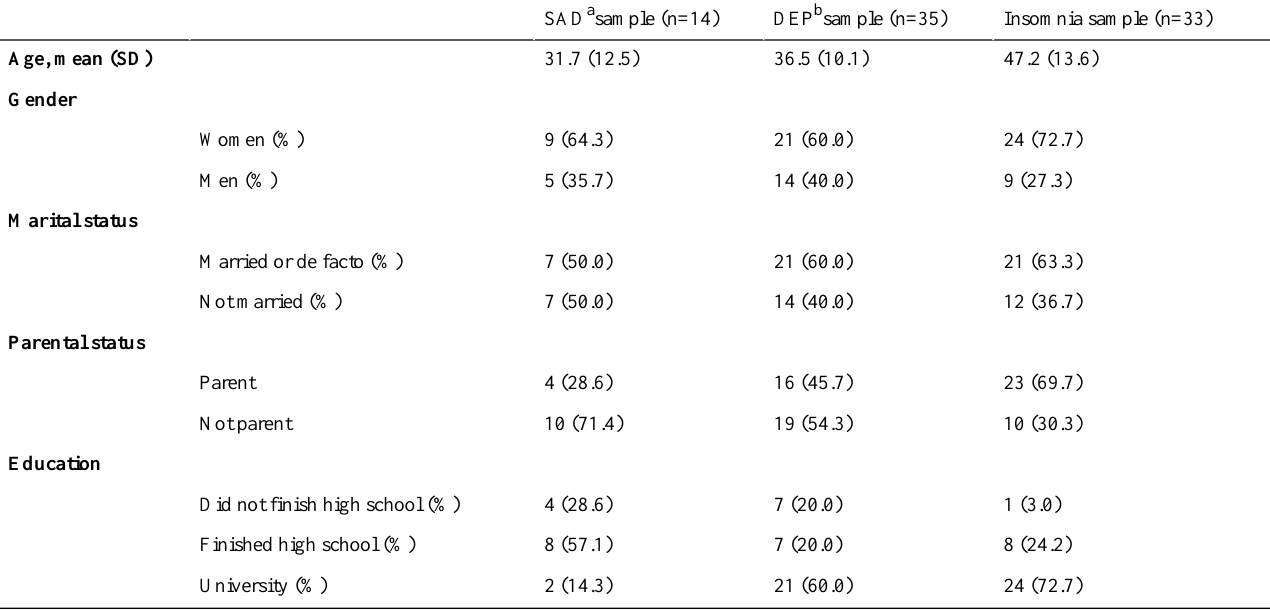
Table 1. Description of the